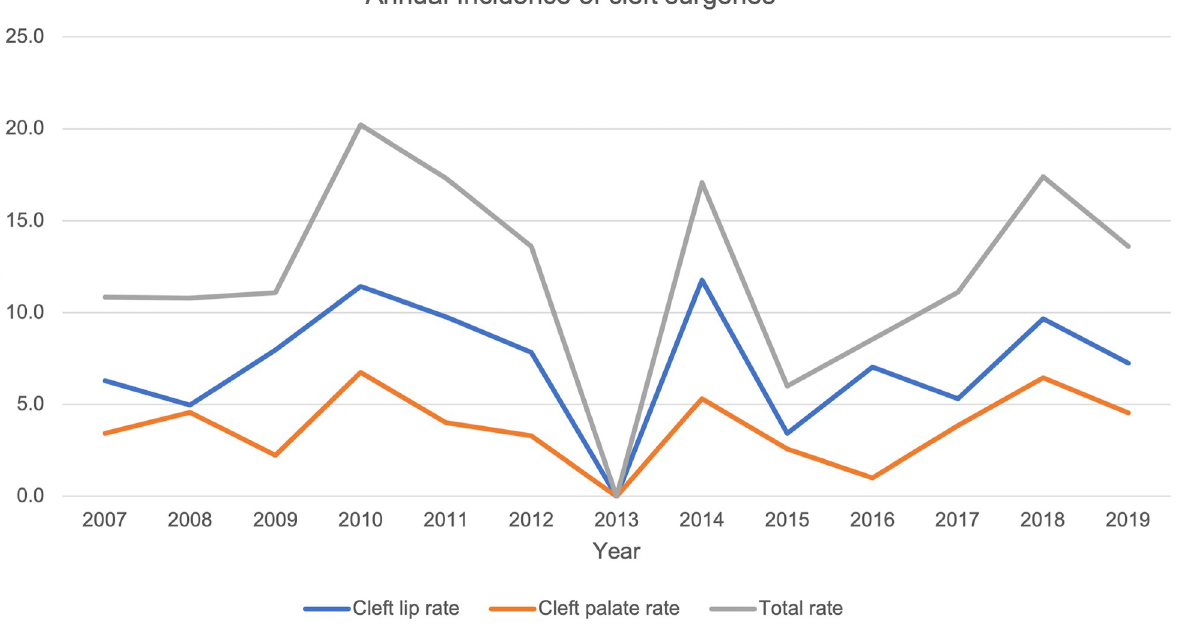
Fig 2. Annual incidence of cleft surgeries per 1000 live